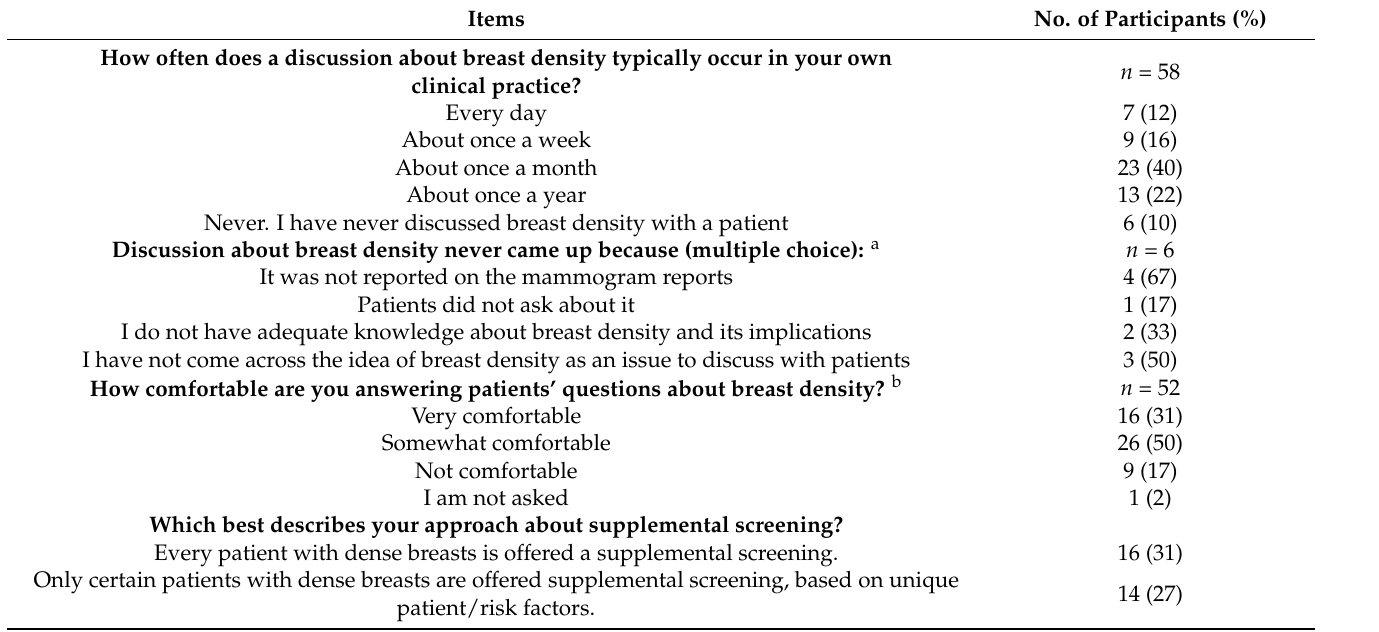
Table 3. Prior experiences and